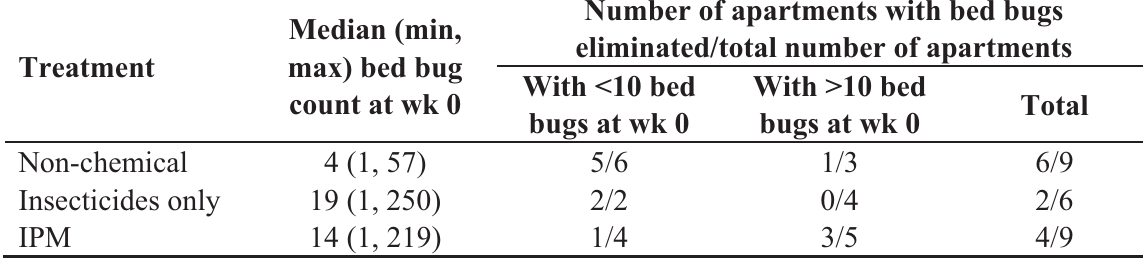
Table 1. Effectiveness of three bed bug treatment strategies after 10 weeks.